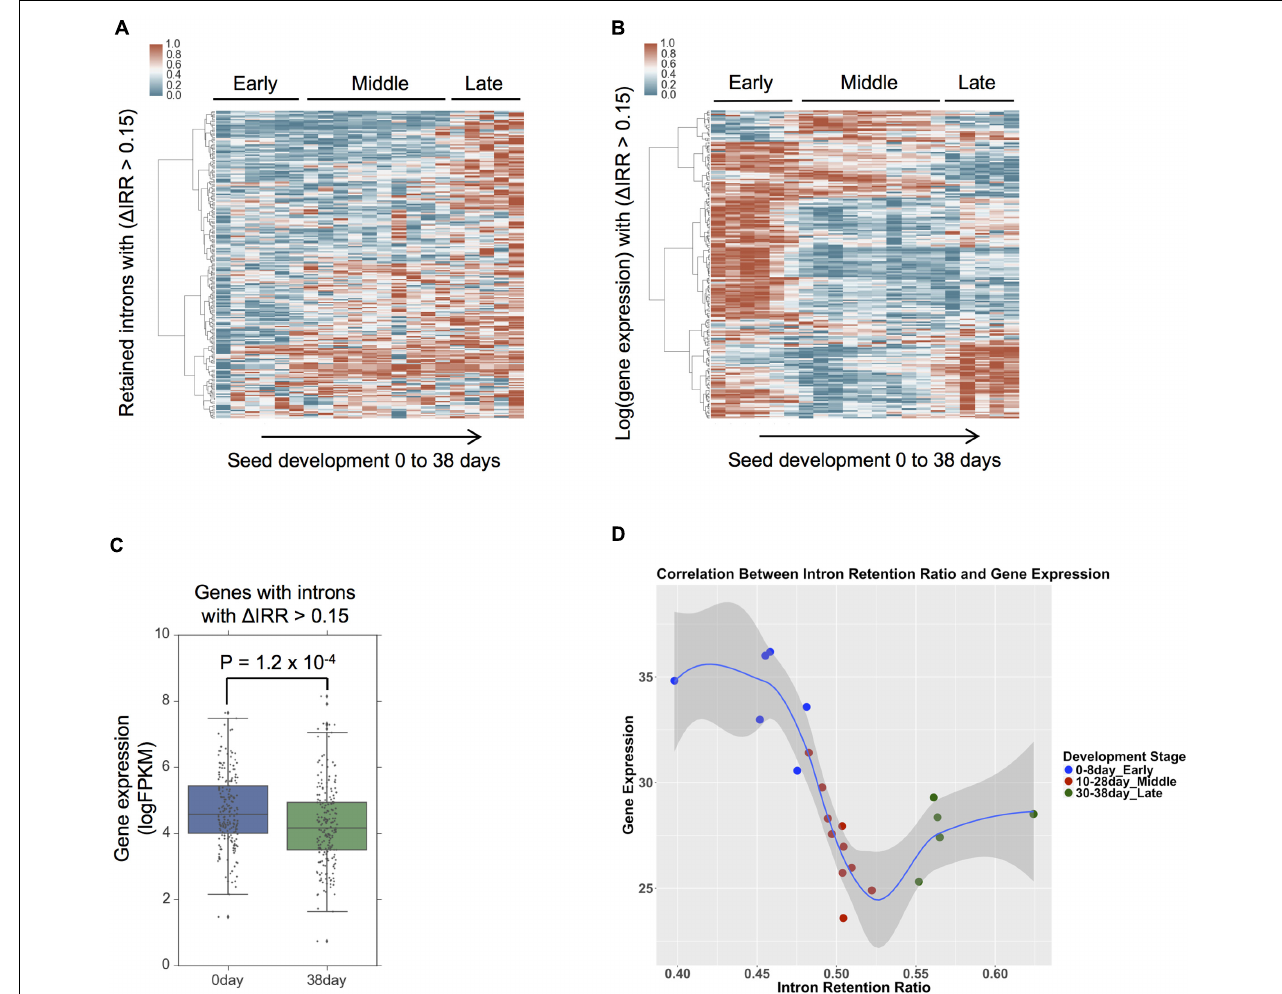
FIGURE 3 | Intron retention dynamics during seed development. (A) Intron retention isoforms require a minimum FPKM of 1 and intron retention ratio (IRR) values between 0.05 and 0.95 from 0 to 38 days across all seed development stages. Hierarchical clustering the IRR values (cid:49) (day 38–day 0) > 0.15 using the Ward’s method. (B) Identification of gene expression values for those intron retention events in (A) , hierarchical clustering was based on log transformed gene expression values. (C) A comparison of expression levels at seed development 0 and 38 day from genes that produce intron retention events with IRR values (cid:49) (38 day–0 day) > 0.15, p -value was calculated by Student’s t -test. (D) Gene expression and IRR trends across different stages of seed development. Each point represents a sample. The average IRR from genes that exhibit IR ( (cid:49) IRR > 0.15) is plotted against their average gene expression across